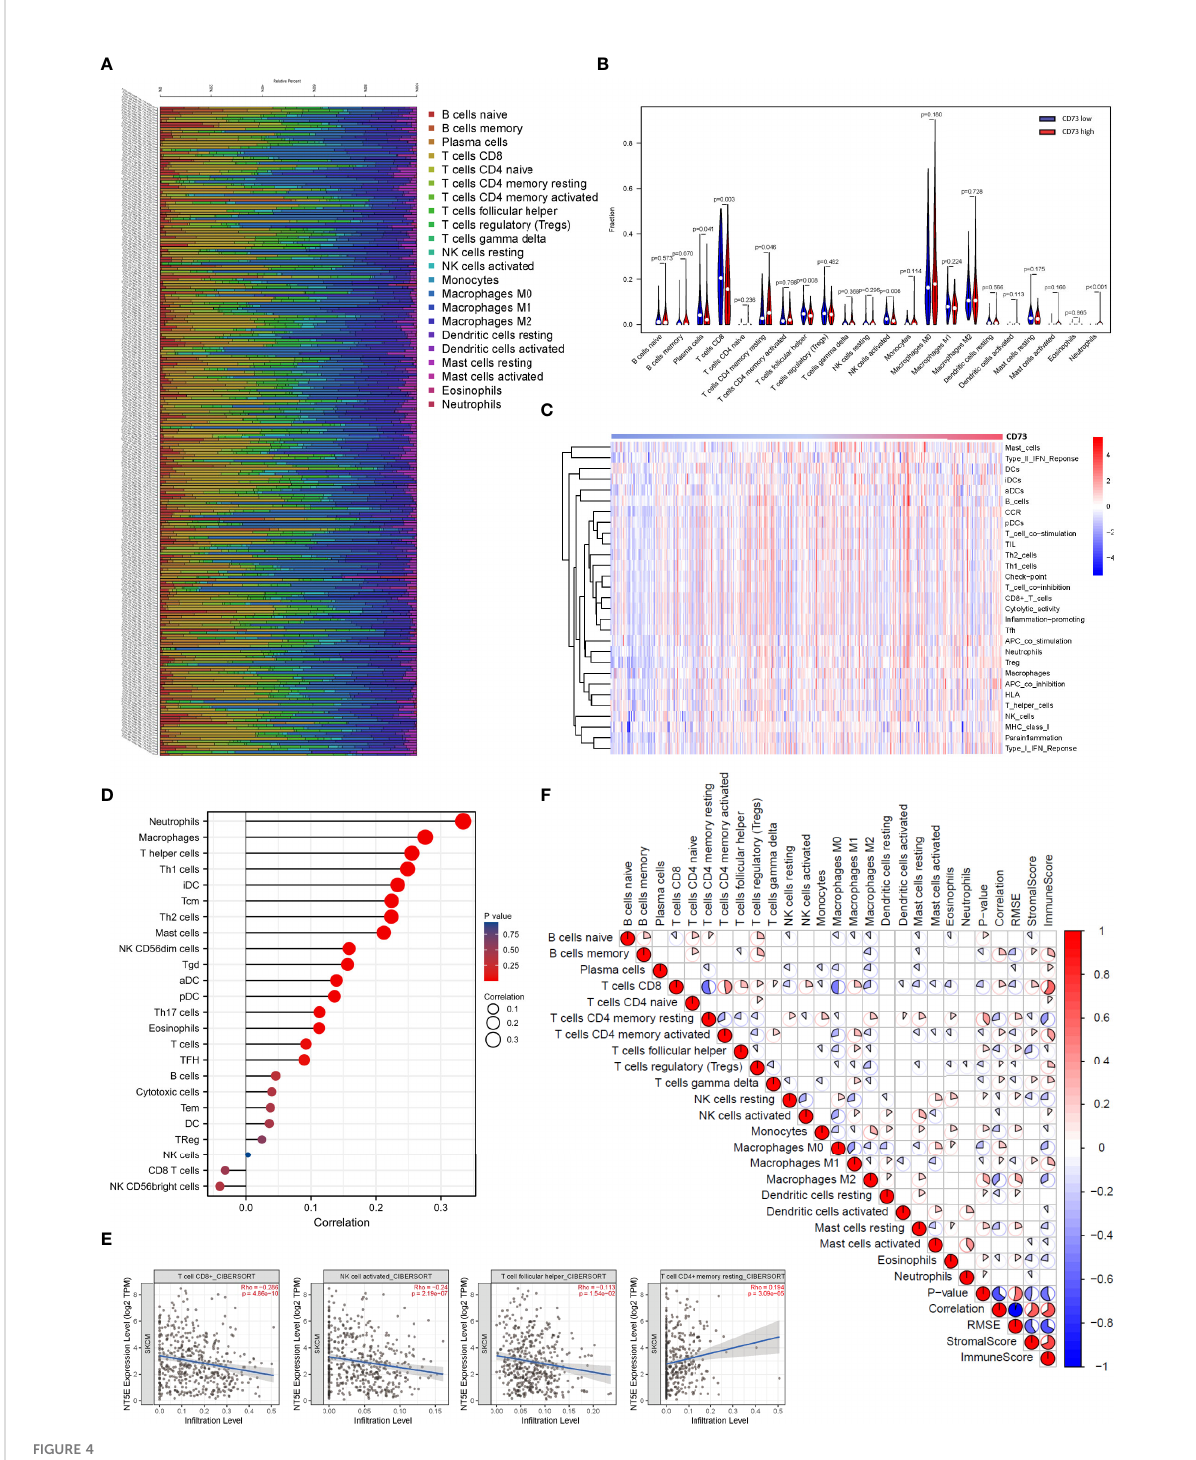
FIGURE 4 Correlations between CD73 expression and immune in fi ltration levels in the TCGA cohort. The immune in fi ltration patterns in 471 tumor tissues arranged by CD73 expression (A) . Differential analysis of immune cells between CD73 high and CD73 low groups in TCGA (B) . Detection of the correlation between the CD73 expression level and a series of immune cells using ssGSEA analysis (C, D) . CD73 expression was signi fi cantly inversely correlated with in fi ltration of CD8 + T cells, activated NK cells and follicular helper T cells, while considerably positively correlated with in fi ltration of resting memory CD4 + T cells (E) . Heatmap showed the correlation between representative immune cells in fi ltration (F)